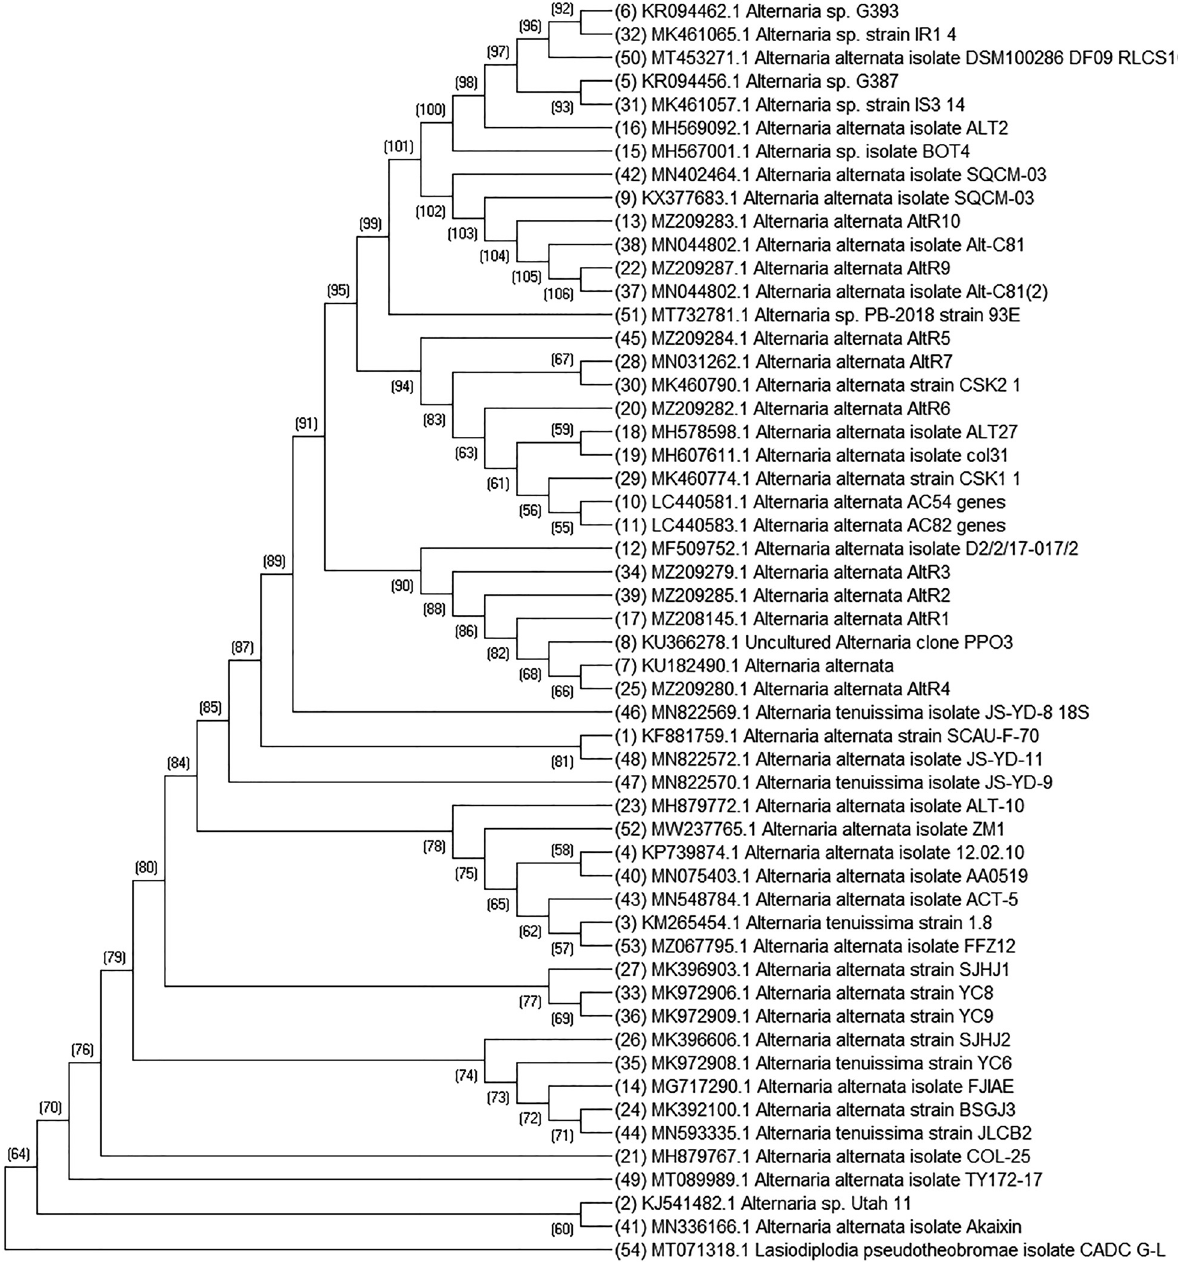
Figure 4: Phylogenetic tree based upon CLUSTALW alignmentof internal transcribedspacer region nucleotideof Alternaria alternata isolates obtained from loquat